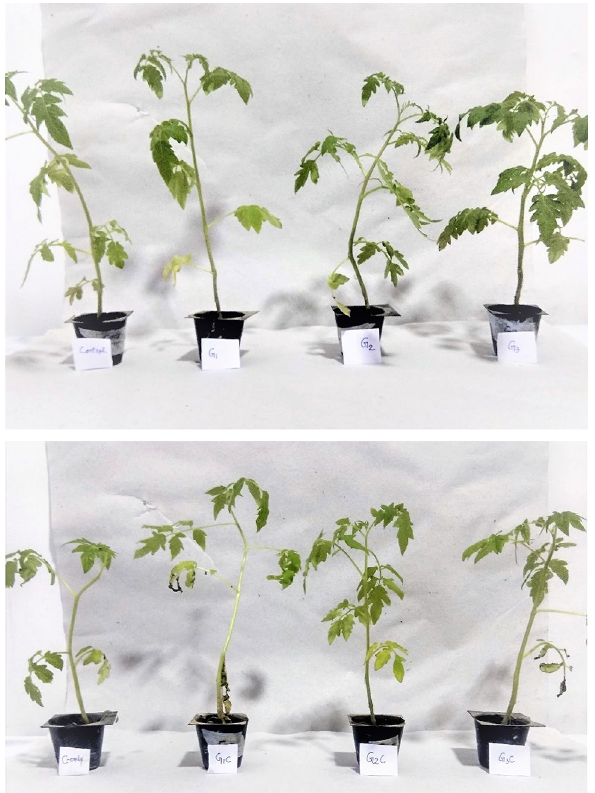
Figure 2. Effect of cold stress and different GSH concentration in shoot morphology. Control (Con): 25/18 °C + 0 mM GSH, G1: 25/18 °C + 0.5 mM GSH, G2: 25/18 °C + 1 mM GSH, G3: 25/18 °C + 2 mM GSH,